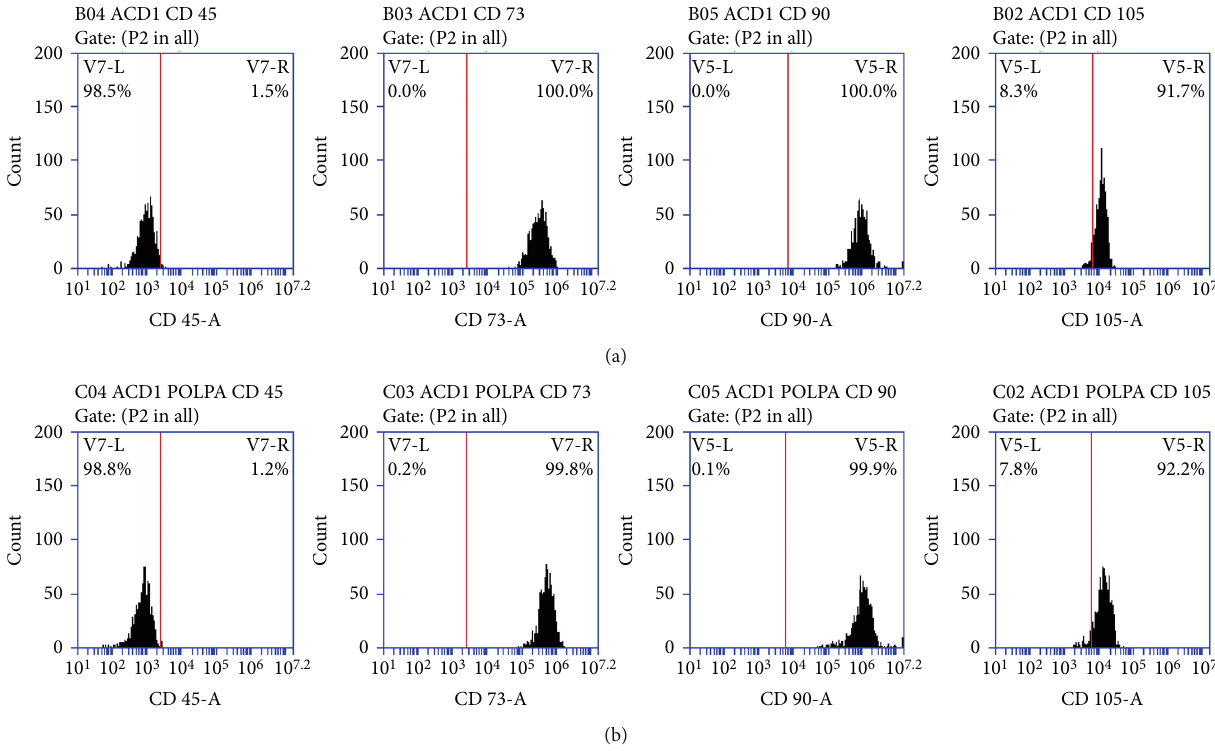
Figure 3: CD45, CD73, CD90, and CD105 marker expression pro fi le: (a) control group and (b) test